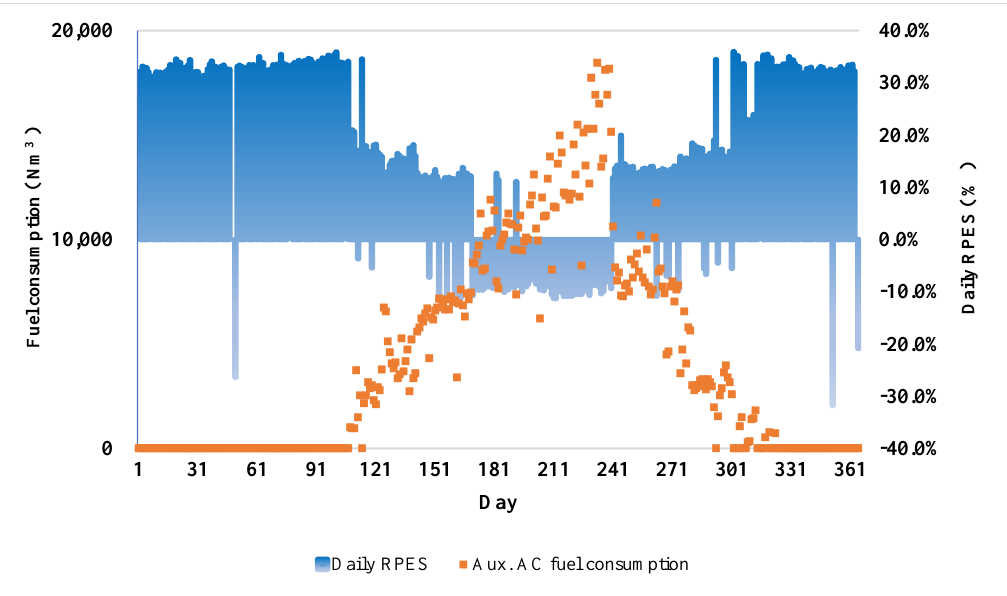
Figure 17. Profiles of the daily RPES and the LNG consumption for auxiliary absorption chillers for Case A.